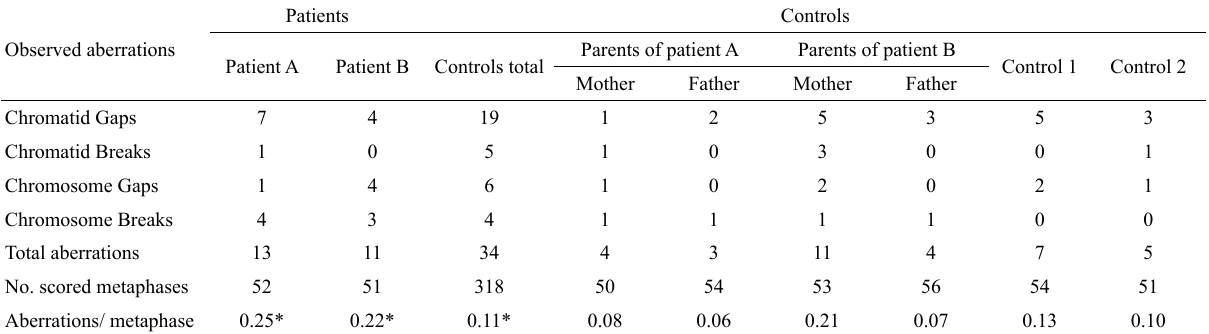
Table 1 – Spontaneous chromosomal instability in peripheral blood cells from two unrelated patients with a Rothmund-Thomson-like phenotype.